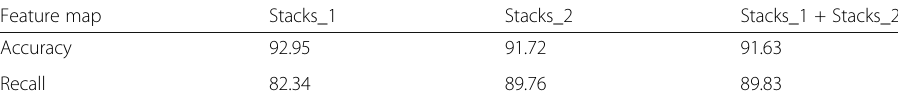
Table 2 Comparison of the output results of the middle part features